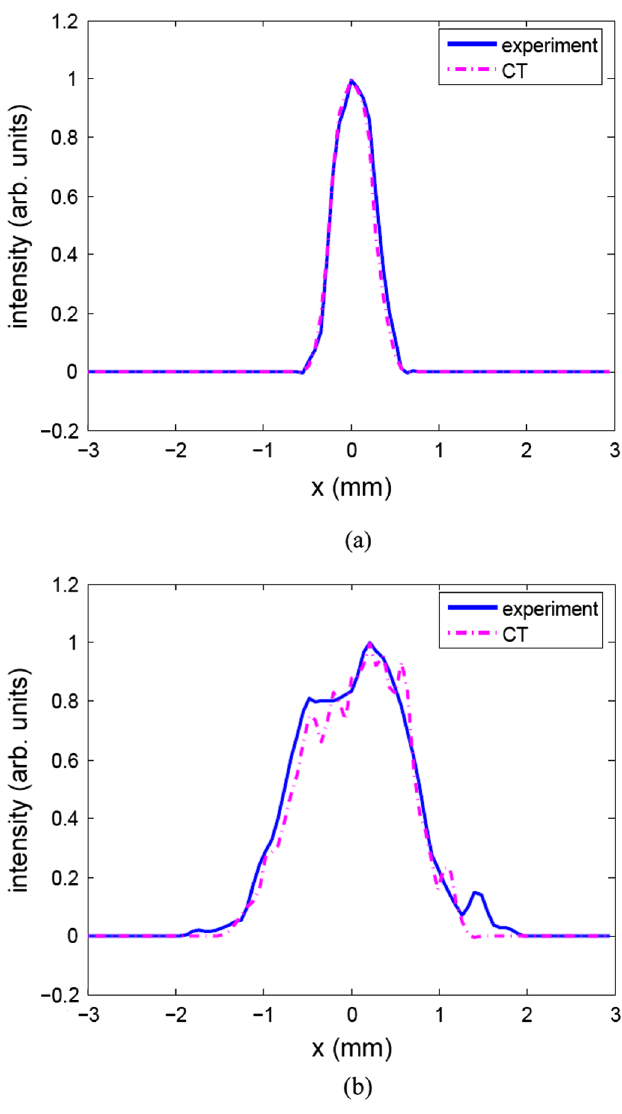
FIG. 7. (Color) Beam profiles from measurement and those from the CT technique for various solenoid currents: (a) for 76 A and (b) for 82 A.